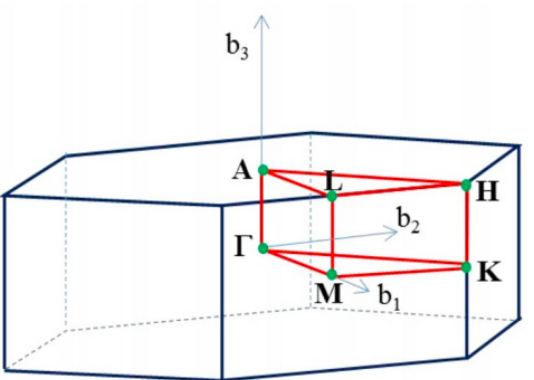
Figure 2. The Brillouin zone and special point of the hexagonal lattice system of tungsten disulfide. Reproduced with permission [36]. Copyright 2015, MDPI.